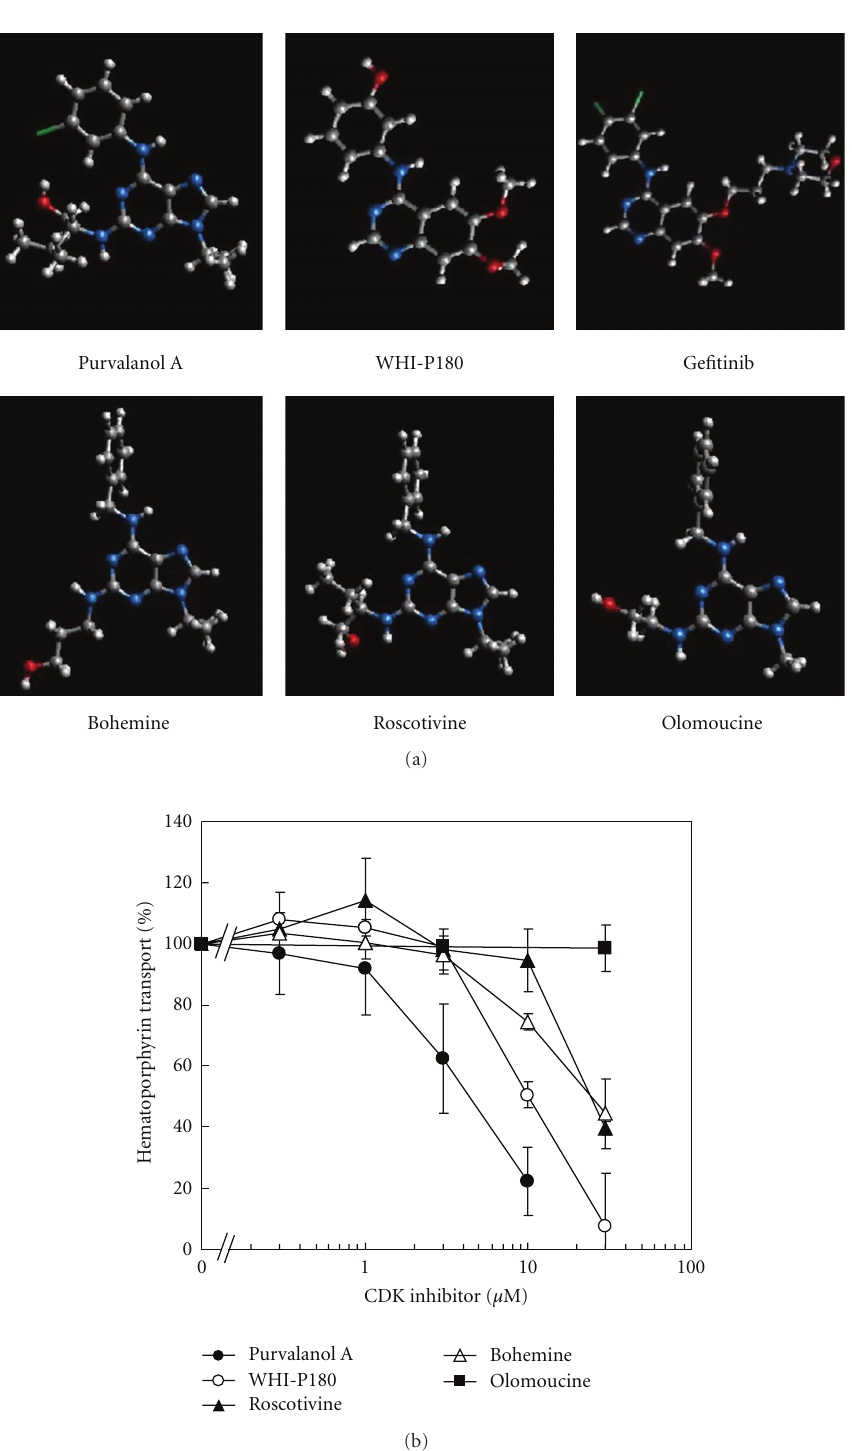
Figure 5: (a) Chemical structures of CDK inhibitors: purvalanol A, WHI-P180, gefitinib, bohemine, roscovitine, and olomoucine. (b) Inhibition of ABCG2-mediated hematoporphyrin transport by purvalanol A, WHI-P180, roscovitine, bohemine, or olomoucine. ABCG2- expressing plasma membrane vesicles (20 μ g of protein) were incubated with 20 μ M hematoporphyrin in the presence of purvalanol A, WHI-P180, roscovitine, bohemine, or olomoucine (final concentration: 0, 0.3, 1, 3, 10, or 30 μ M) in the standard incubation medium (0.25M sucrose and 10mM Tris/HEPES, pH 7.4, 1mM ATP, 10 mM creatine phosphate, 100 μ g/mL of creatine kinase, 10 mM MgCl 2 ) at 37 ◦ C for 10 min. Hematoporphyrin transported into membrane vesicles was detected [43]. Data are expressed as mean values ± SD ( n =